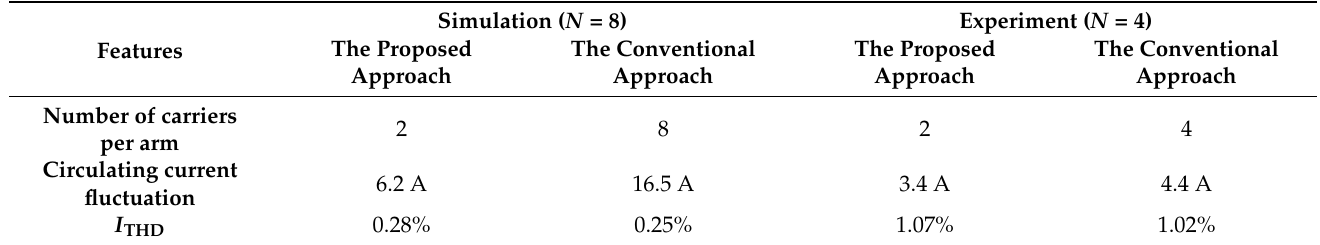
Table 5. Features of the different approaches at cos φ = 0.623.